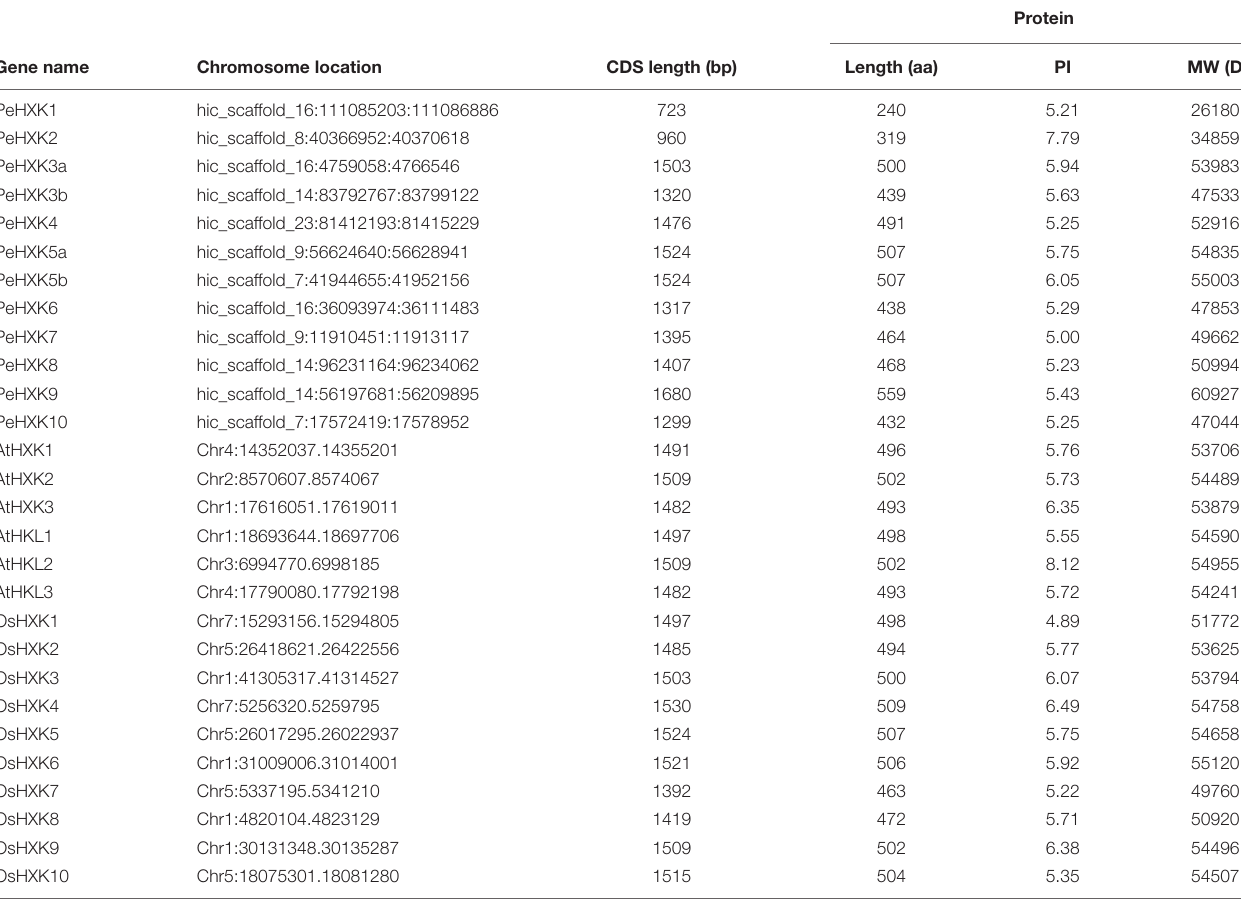
TABLE 1 | Detailed information about HXKs in moso bamboo, Arabidopsis thaliana , and rice.